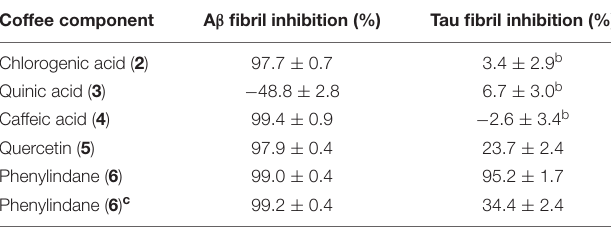
TABLE 4 | Inhibition of A β and tau fibril formation by 2 – 6 in ThT and ThS fluorescence assays.